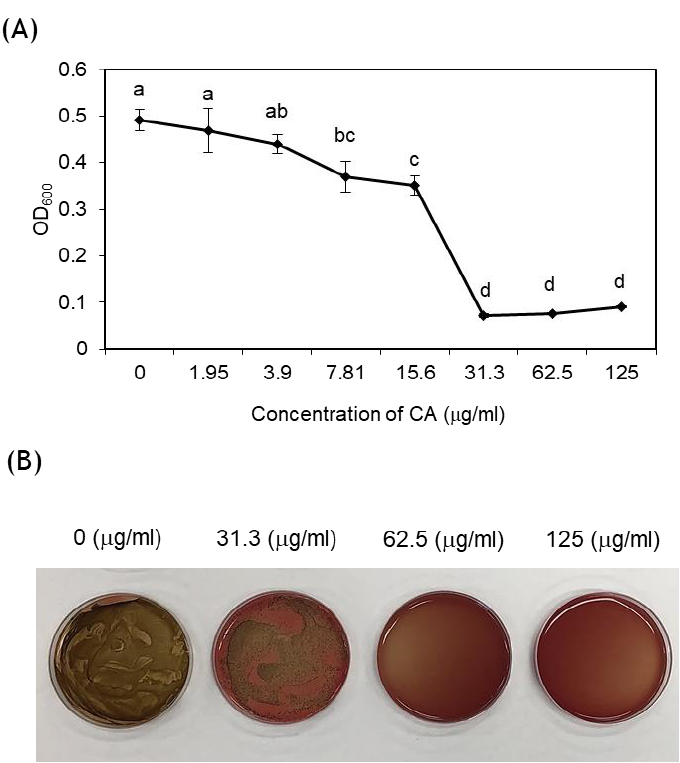
Figure 3. Antibacterial effects of Colocasia antiquorum var. esculenta extract (CA) treatments against P. gingivalis . ( A ) The minimum inhibitory concentration of CA. Different lowercase letters indicate significant differences between groups detected by one-way analysis of variance (ANOVA) with Tukey’s multiple comparisons ( α ≤ 0.05). ( B ) The minimum bactericidal concentration of CA. At concentrations of 62.5 μg/mL or more, P. gingivalis did not form colonies.